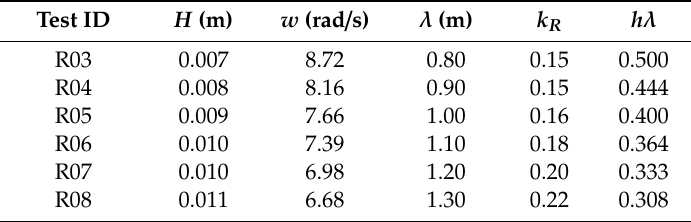
Table 2. Test ID and values of H , w and λ , h / λ and k R , characterizing the experimental conditions. Test ID H